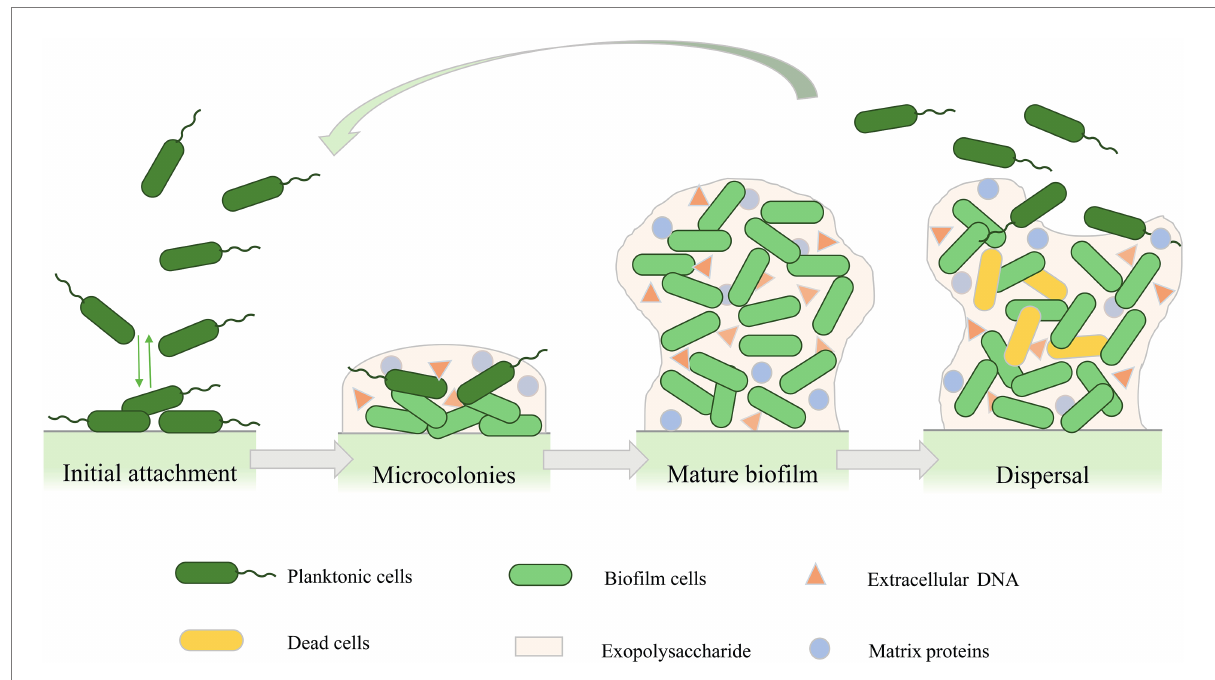
FIGURE 1 Cycle of Pseudomonas aeruginosa biofilm development. Biofilm formation includes four stages: initial attachment, microcolonies, mature biofilm, and biofilm